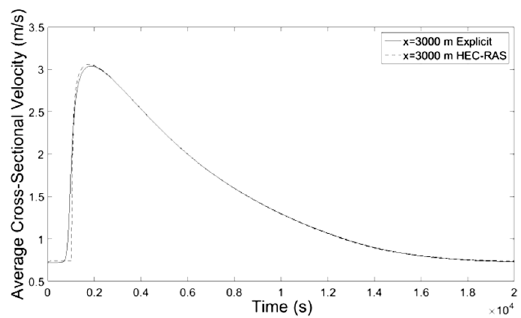
Figure 6. Average Velocity-Time at x = 3000 m.